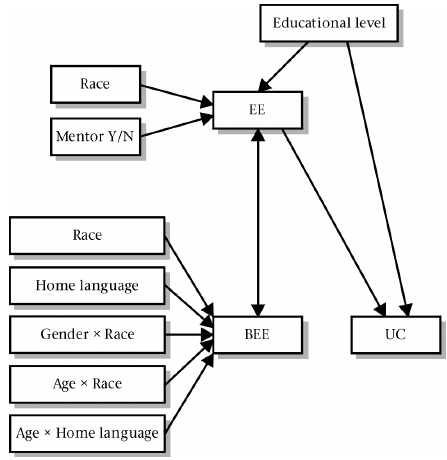
Figure 15: An Integrated predictive model of union